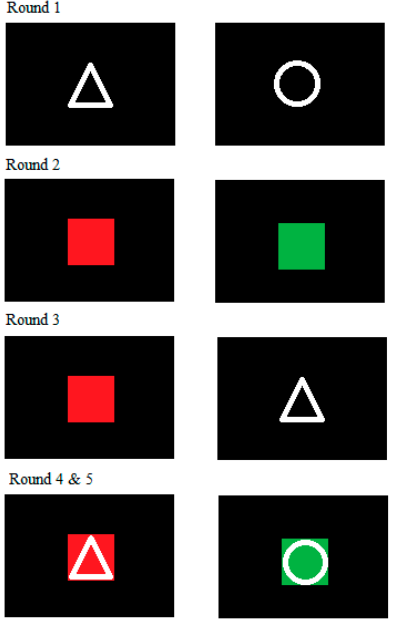
Figure 2. Visual representation of the color-shape test.